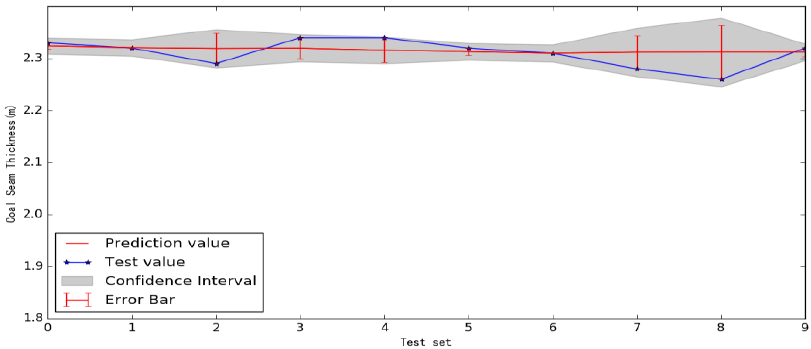
Figure 12. Prediction results obtained by using the proposed STTP-GPR algorithm and real coal seam data.